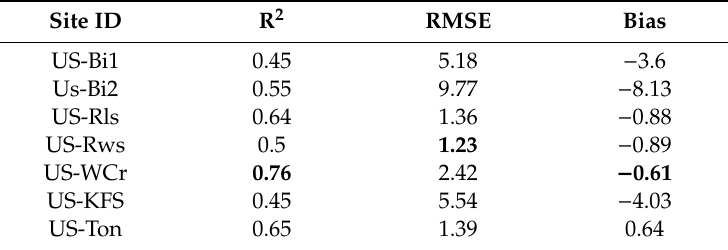
Table 3. Coe ffi cient of determination (R 2 ), root mean square error (RMSE, g C m − 2 d − 1 ) and